Question: Briefly state, in one sentence, what is plotted here.
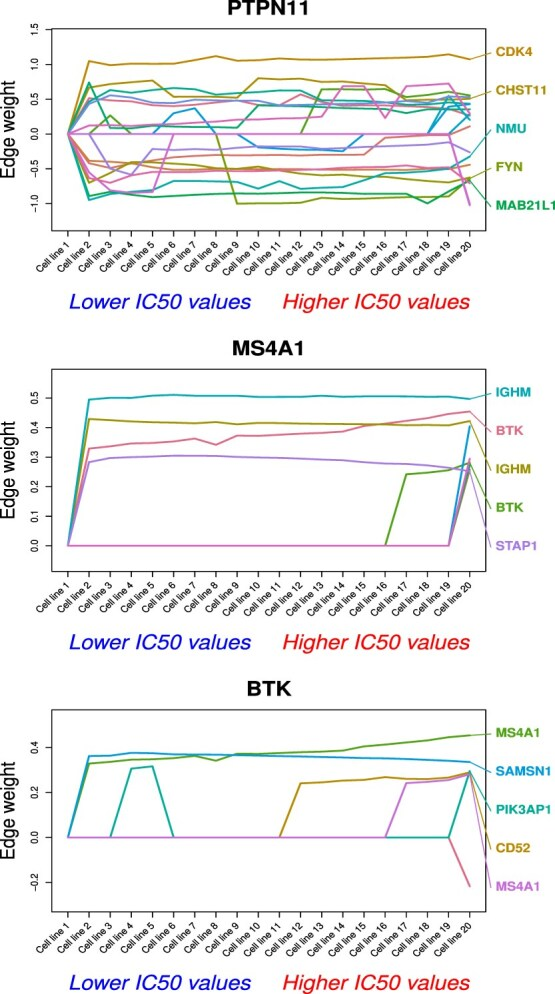
Answer: Edge weight trajectories of the marker genes (PTPN11, MS4A1, and BTK) across cell lines ordered according to increasing IC50 values for imatinib, quizartinib, and ruxolitinib. The x-axis represents cell lines continuously ordered along the IC50 spectrum from lower to higher IC50 values, and the y-axis represents edge weights. To improve visualization clarity, only representative interaction partners with the largest absolute edge weights are labeled in the figure. The complete edge weight trajectories across all interaction partners and cell lines are provided in Supplementary Table S2 .